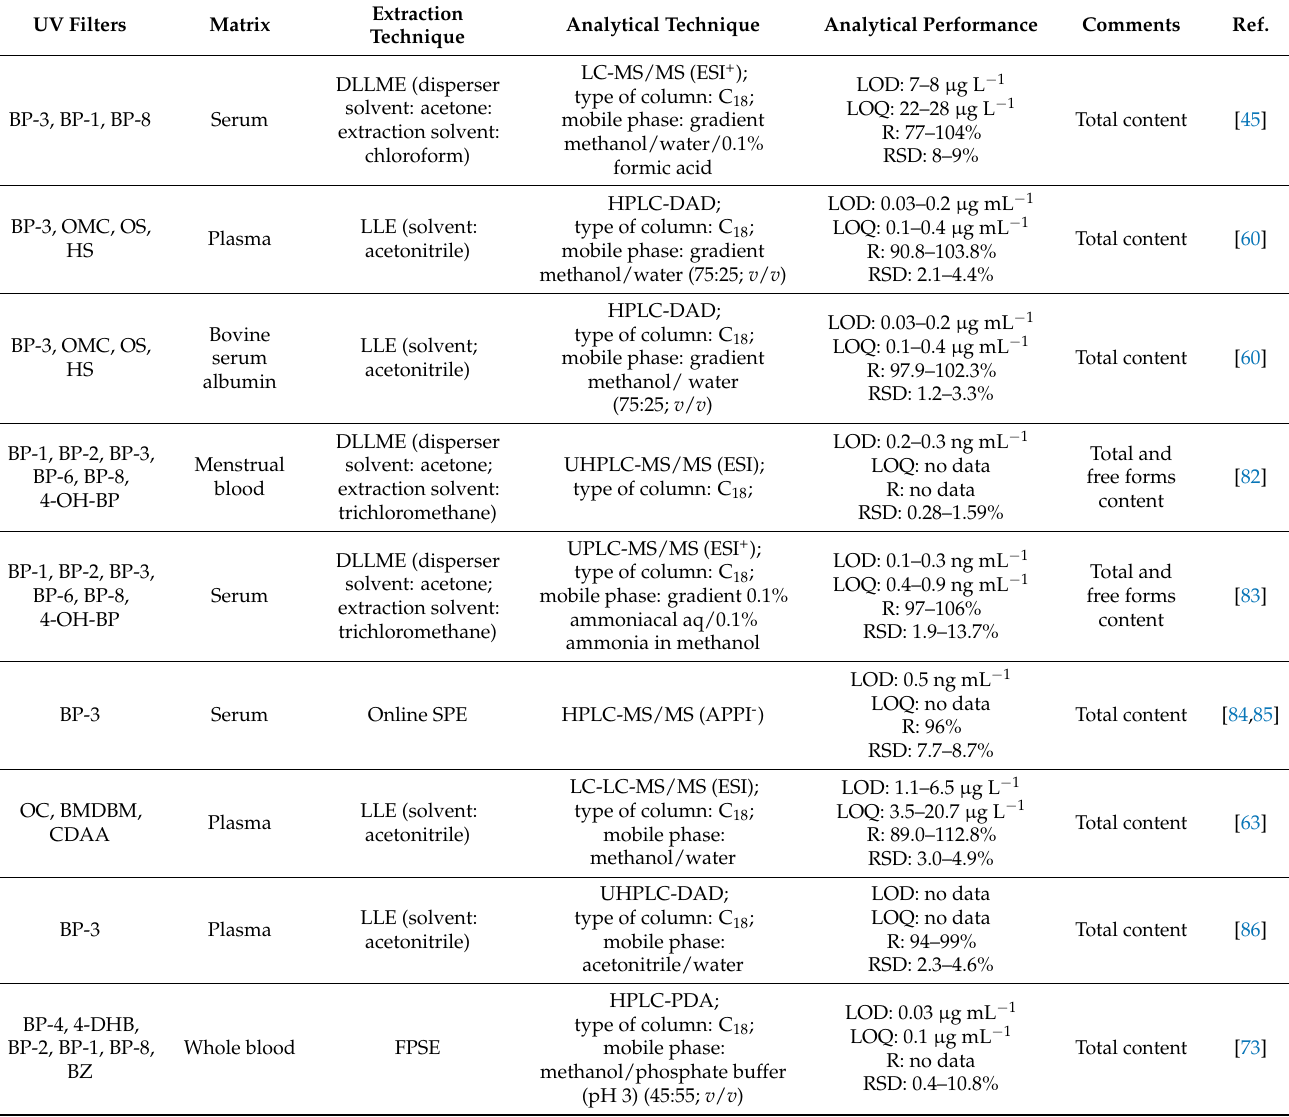
Table 4. Published studies on UV filters determination in blood, plasma, and serum. UV